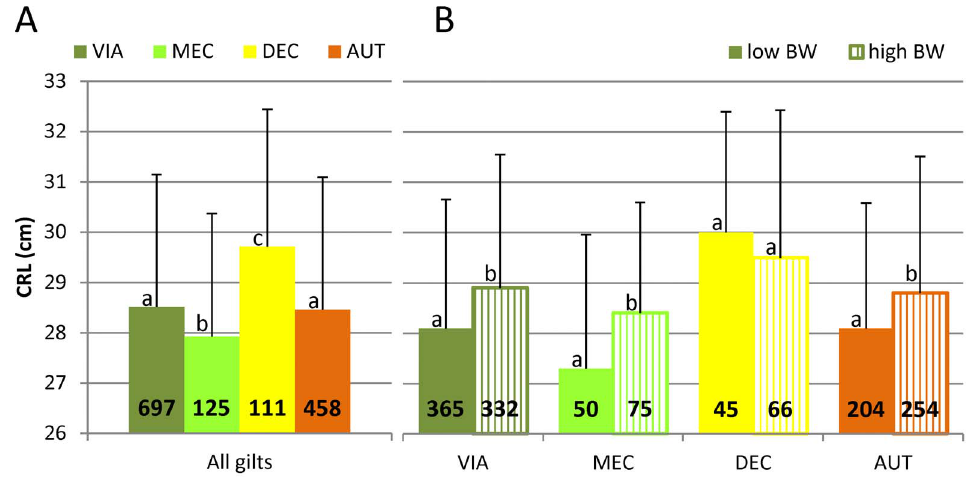
Figure 3. Comparison of fetal crown-rump-length across preservation categories. The mean crown-rump-length (CRL, cm) is presented for fetuses across preservation categories at 21 days after PRRSv inoculation (gestation day 106 6 1). A) All gilts regardless of birth weight; B) Low (solid bars) and high (lined bars) BW gilts. Bars represent standard deviation; values indicate the number of fetuses within each preservation category; letters indicate significant differences ( P , 0.05) between preservation categories (A) or between low and high BW gilts within one preservation category (B). Viable (VIA) and meconium stained (MEC) fetuses were alive at termination, while decomposed (DEC) and autolyzed (AUT) fetuses were dead.